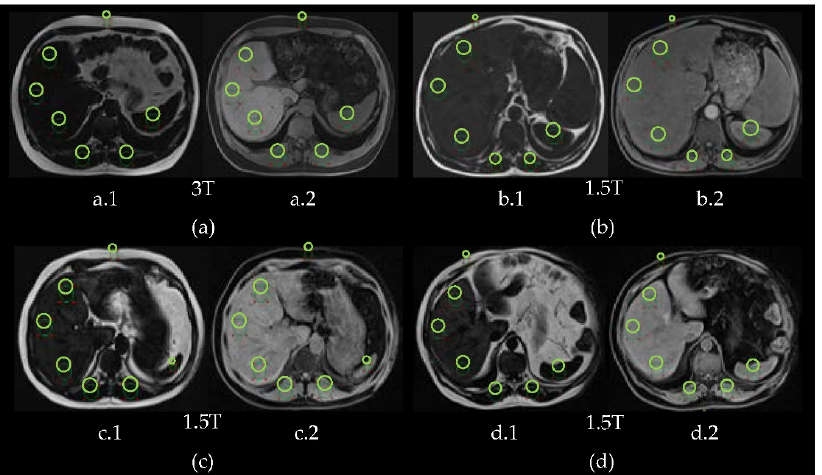
Figure 5. Fat-only images ( a.1 , b.1 , c.1 , d.1 ) and water-only images ( a.2 , b.2 , c.2 , d.2 ) of patients #3, #4, #5 and #6. In each image there are 3 ROIs in the liver, 2 ROIs in paravertebral muscles, 1 ROI in spleen and 1 ROI in abdominal fat. ( a ) Patient #3 (acquired at 3T): no steatosis (FF = 3.1 ± 1.7%). ( b ) Patient #4 (acquired at 1.5T): mild steatosis (FF = 16.8 ± 1.6%). ( c ) Patient #5 (acquired at 1.5T): moderate steatosis (FF = 17.5 ± 2.4%). ( d ) Patient #6 (acquired at 1.5T): severe steatosis (FF = 24.8 ±